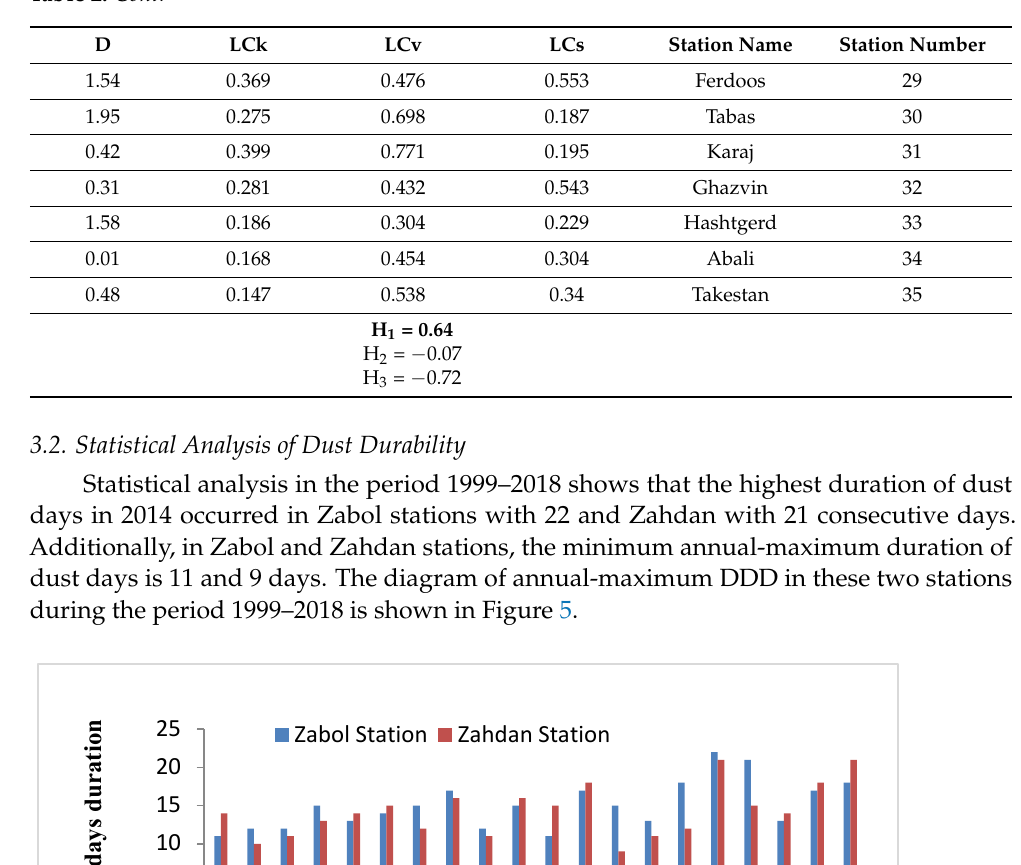
Figure 5. Annual-maximum dust days duration in Zabol and Zahdan stations 1999–2018. A seasonal survey of the index station of the region (Zabol and Zahdan stations) shows that the highest frequency of dust events occurs in summer, followed by spring; in particular, in Zahdan and Zabol stations about 52% and 48% of multiday dust storms occurred in summer; their diagrams are shown in Figure 6. The most important reasons for the high frequency of dusty days in this area in summer, include high temperatures that cause severe evaporation of water resources along with lack of rainfall in summer, all leading to reduced adhesion of soil particles due to lack of moisture. Dust emissions are worsened by the 120-day erosive winds of Sistan that blow in summer and strongly affect the eastern parts of Iran Figure 6. Seasonal diagram of multiday dust events at Zabol and Zahdan station . After Zabol station with 22 days and Zahdan with 21 days, the next longest DDD was recorded at Anar, Nain, and Saveh stations with 8 days, as shown in Figure 7. There is a big difference between the DDD values of Zahdan and Zabol stations and other stations in the study area. Although stations in the central deserts of Iran such as Khor, Biabank, Yazd, and Semnan, also have favorable climatic and edaphic conditions for wind erosion, the Zahdan and Zabol stations are the most affected by the 120-day winds of Sistan, known as the monsoon winds, that blow continuously over prolonged periods.